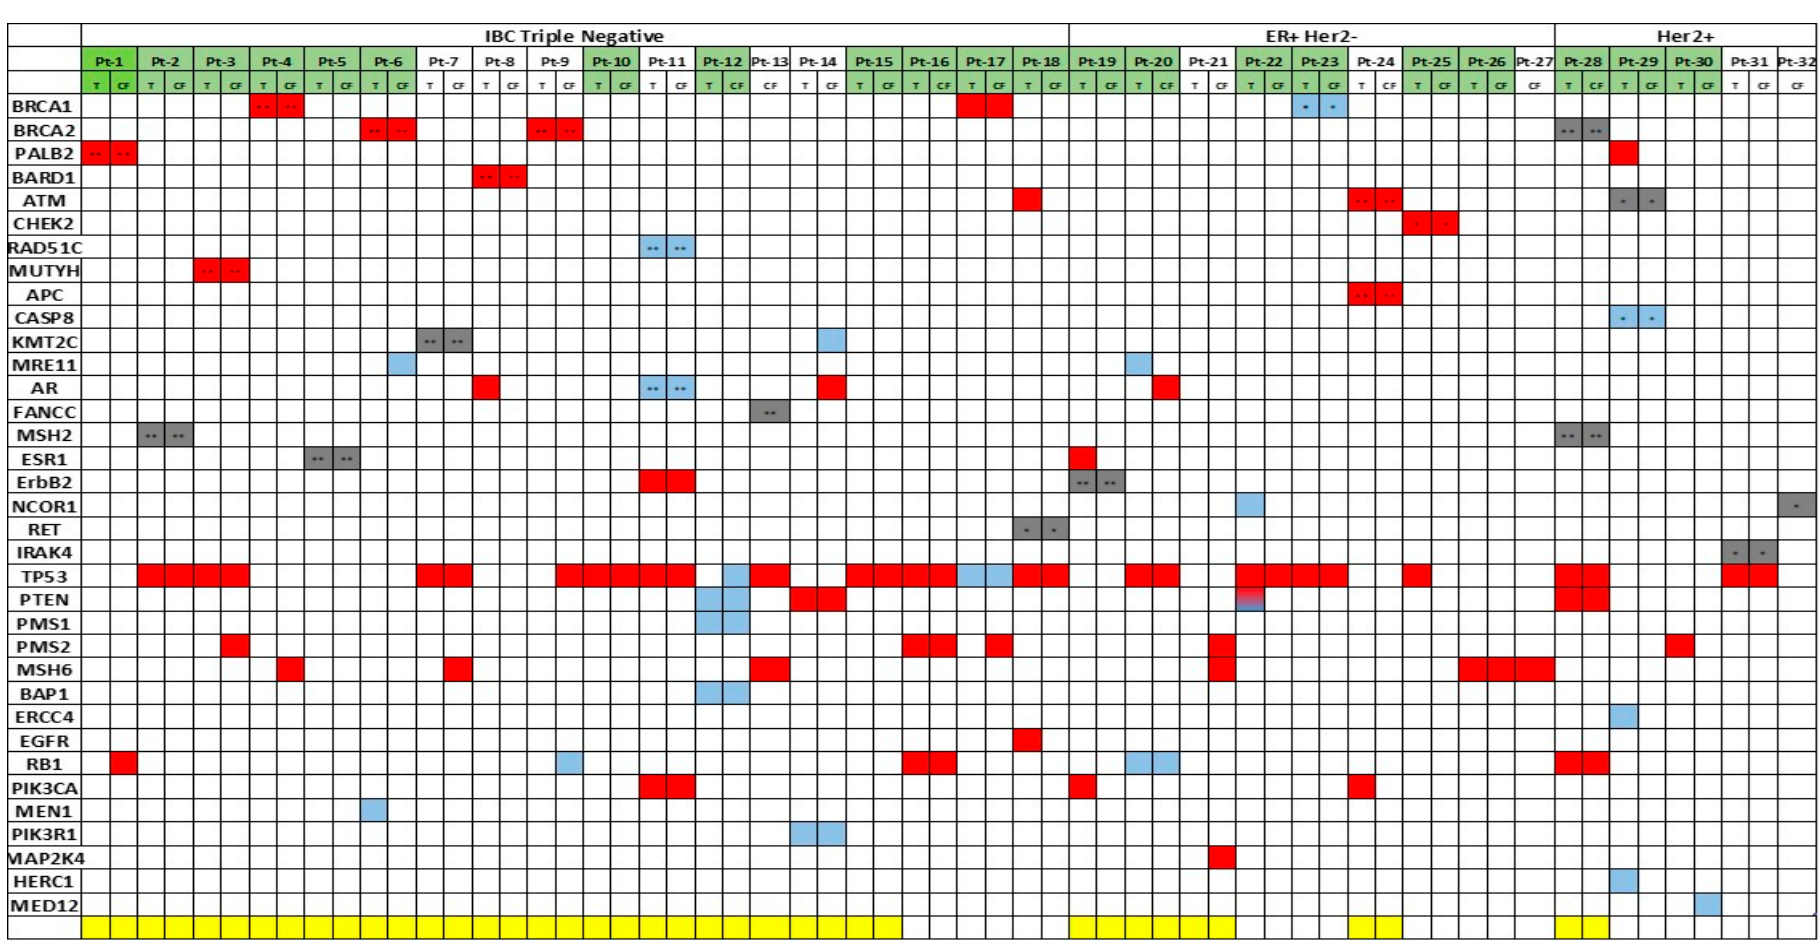
Figure 1. Genetic variants in tumor tissue and paired cfDNA in IBC patients. Germline and somatic variants detected in tumor tissue (T) and/or cfDNA (CF) are indicated for each patient. Pathogenic, likely pathogenic, and variants of uncertain significance are shown in red, blue, and grey, respectively. Samples in which T and CF were collected at the same time point are indicated in green. In yellow, patients in which normal tissue or whole blood samples were also studied by NGS to confirm germline variants. ** Confirmed germline variants. * Putative germline variants. For Pt-1, cfDNAs from month 12 (cfDNA1) and month 22 (cfDNA2) were studied, and the PALB2 variant was detected in both, but the RB1 mutation was only detected in CF from month 22.